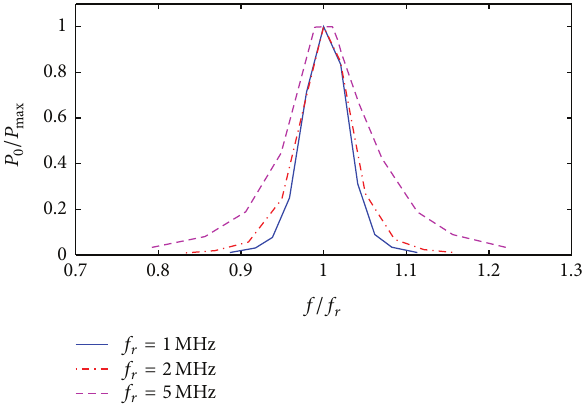
Figure8:Variationsinfrequencyresponsecurveofloadpowerwith various resonance